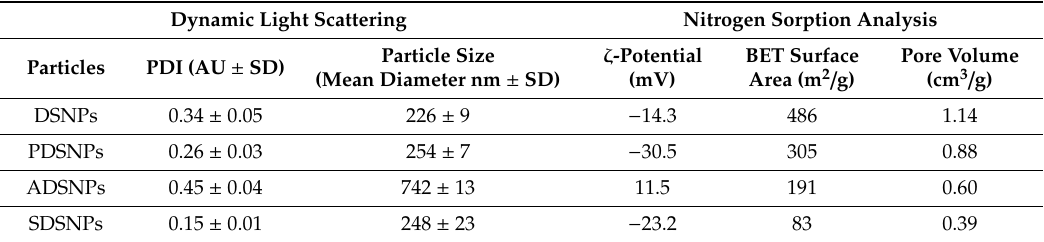
Figure 1. ( a – d ) TEM images of pristine DSNPs, PDSNPs, ADSNPs, and SDSNPs, respectively, showing dendritic morphology with pores radiating from the center; ( e ) particle size distribution showing that ADSNPs follow the trend of aggregation and remaining negatively charged DSNPs exhibit particle size at pH 7.4, agreeable with that of TEM imaging; ( f ) TGA of pristine and functionalized DSNPs. Table 1. Hydrodynamic size, poly dispersity index (PDI), ζ -potential, and BET surface area of DSNPs and derivatives. (SD: standard deviation; BET: